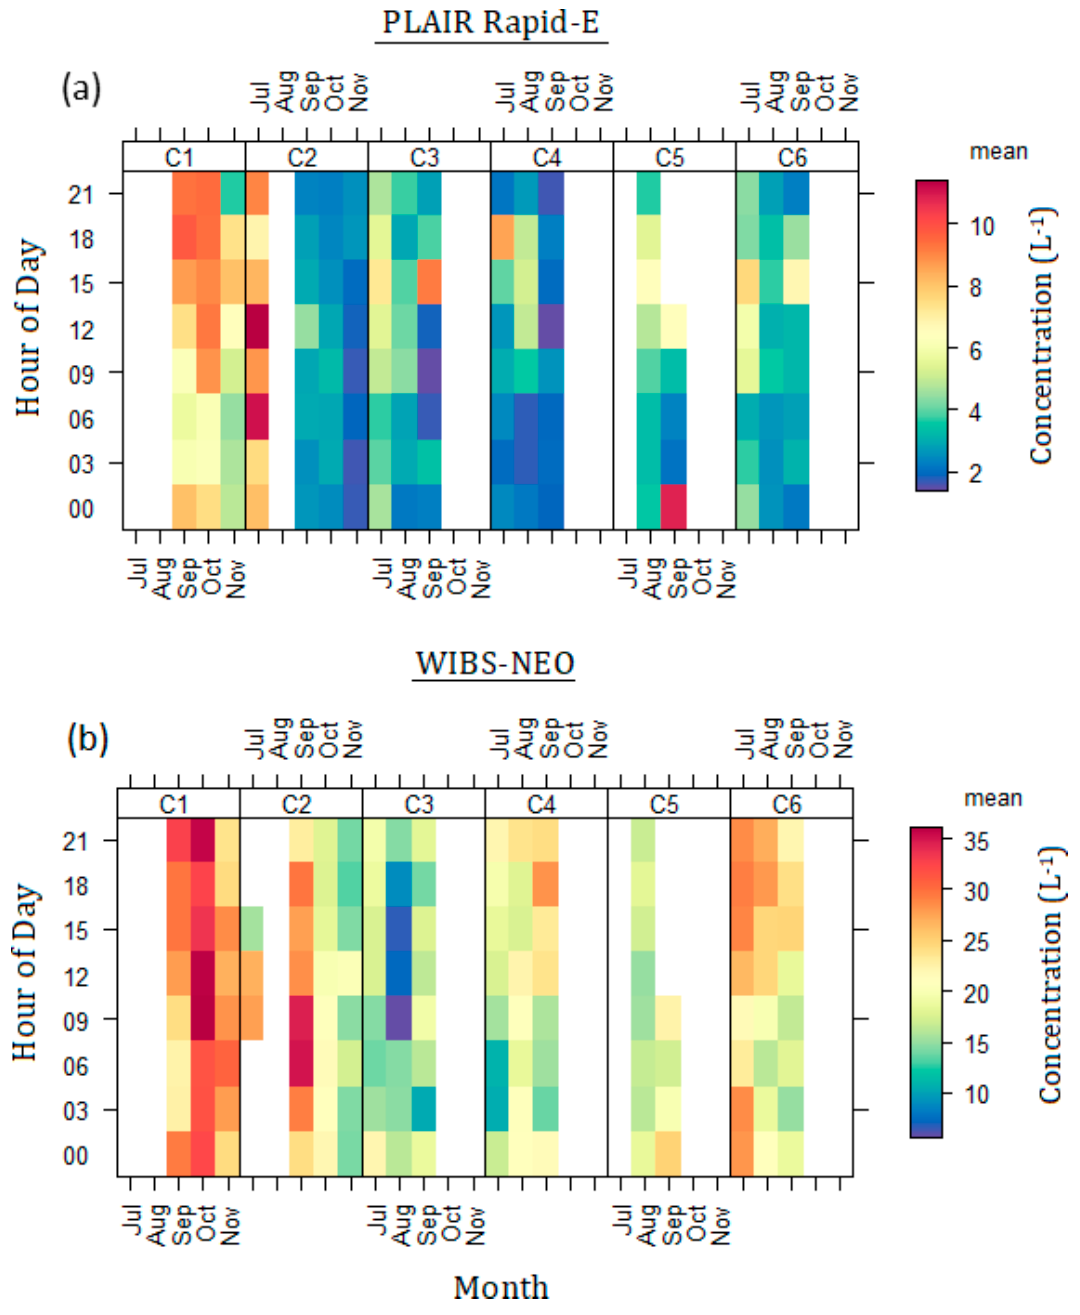
Figure 7. Mean concentrations (L − 1 ) of biofluorescent particles as a function of wind cluster, split by month and hour of day. Concentrations are for particles ≥ 5 µm for the PLAIR Rapid-E and ≥ 0.5 µm for the WIBS-NEO. Concentrations as a function of cluster are calculated in three-hour intervals. Panel ( a ) represents the PLAIR Rapid-E and panel ( b ) represents the WIBS-NEO.